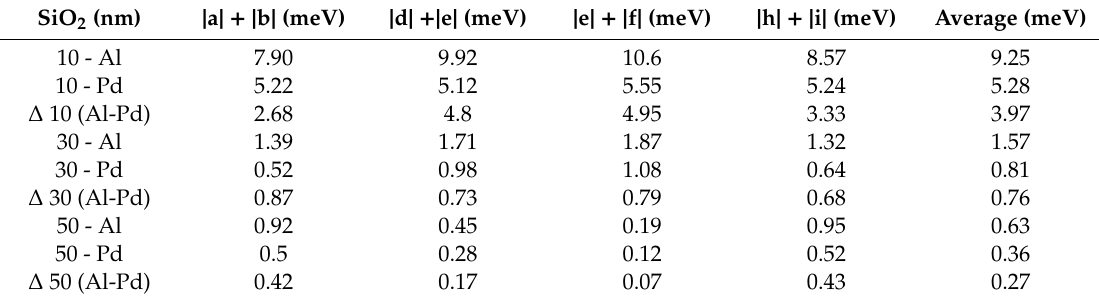
Table 2. Changes in magnitude of the conduction band peaks (a, c, e, g, and i) and valleys (b, d, f, and h) based on Figure 4c. Energy di ff erences between Al and Pd are calculated for SiO 2 at 10 nm, 30 nm, and 50 nm.